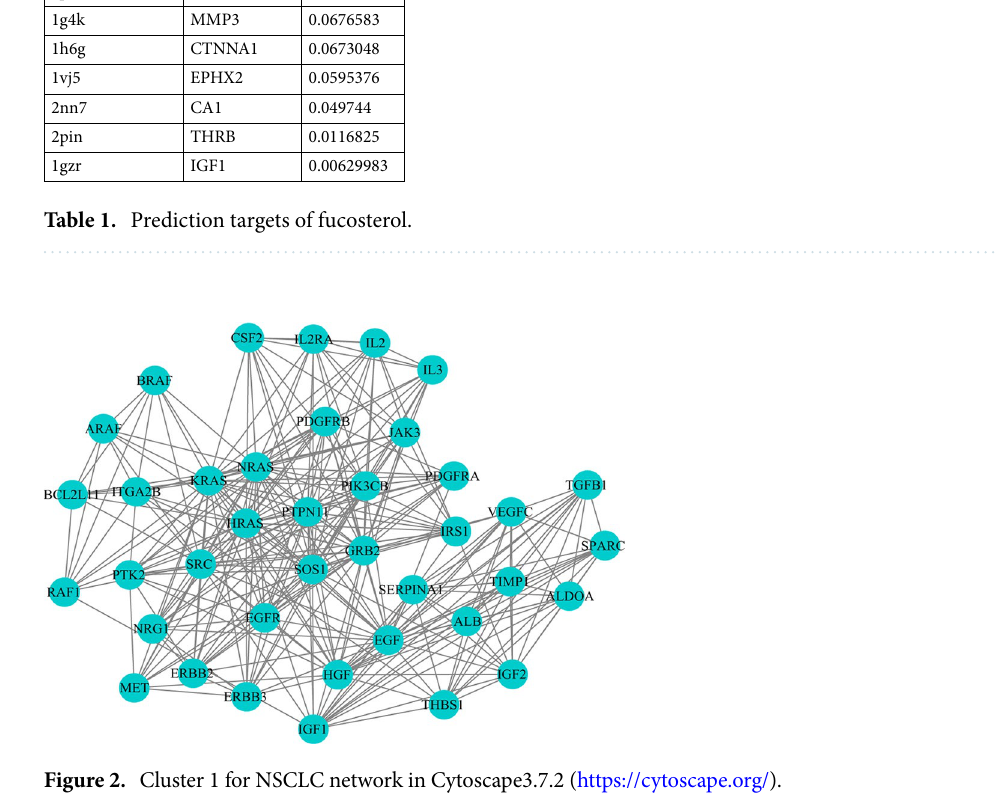
Figure 2. Cluster 1 for NSCLC network in Cytoscape3.7.2 (https ://cytos